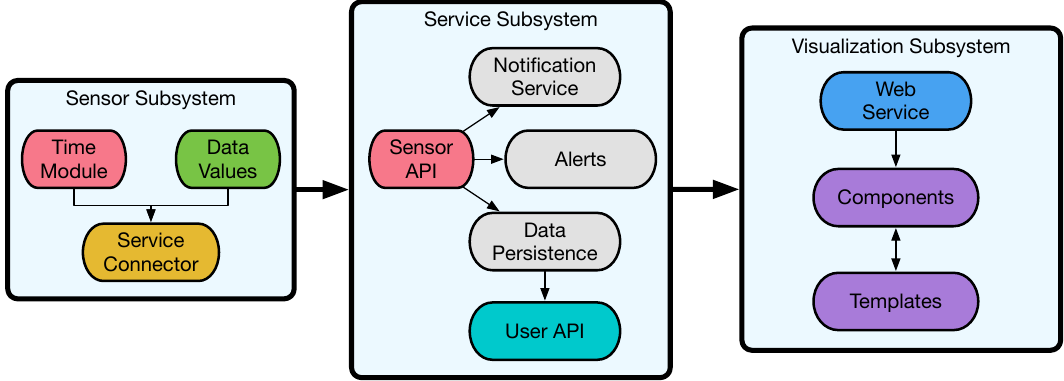
Figure 3. Subsystems that form the radon monitoring